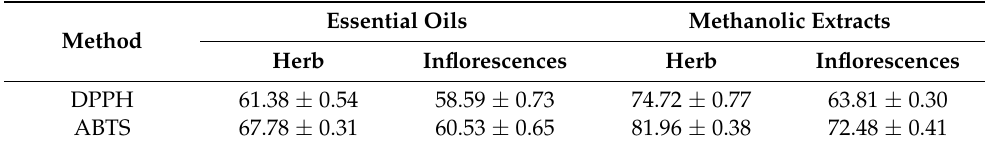
Table 5. Antioxidant activity of essential oils and methanolic extracts (%